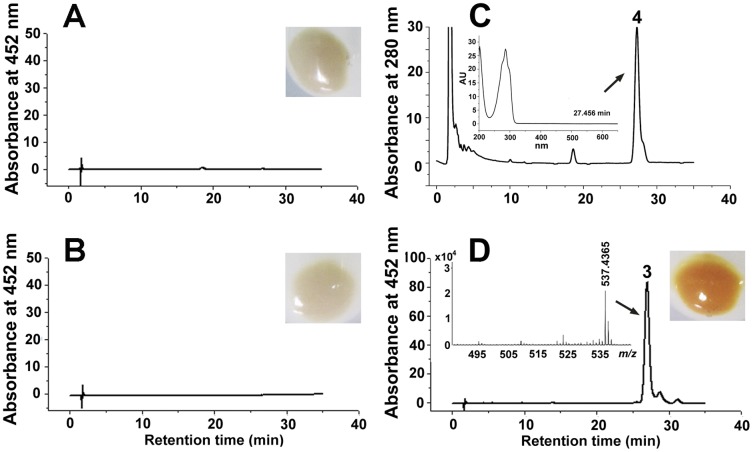
Pigmentation, HPLC analysis and positive-ion APCI-MS spectra of the carotenoids accumulated in E. coli for the functional identification of crtY and crtI.Detection at 452 nm: (A) E. coli containing plasmid pUcrtYI. (B) E. coli containing plasmid pACCRT-EB. (D) E. coli containing pACCRT-EB and pUcrtYI. Detection at 280 nm: (C) E. coli containing plasmid pACCRT-EB. Insets show cell pellets from E. coli transformants with different plasmids. Peak 3, β-carotene ([M+H]+ at m/z = 537.4365). Peak 4, phytoene. The absorption spectrum of peak 4 is shown in the inset in the profile of panel (C).